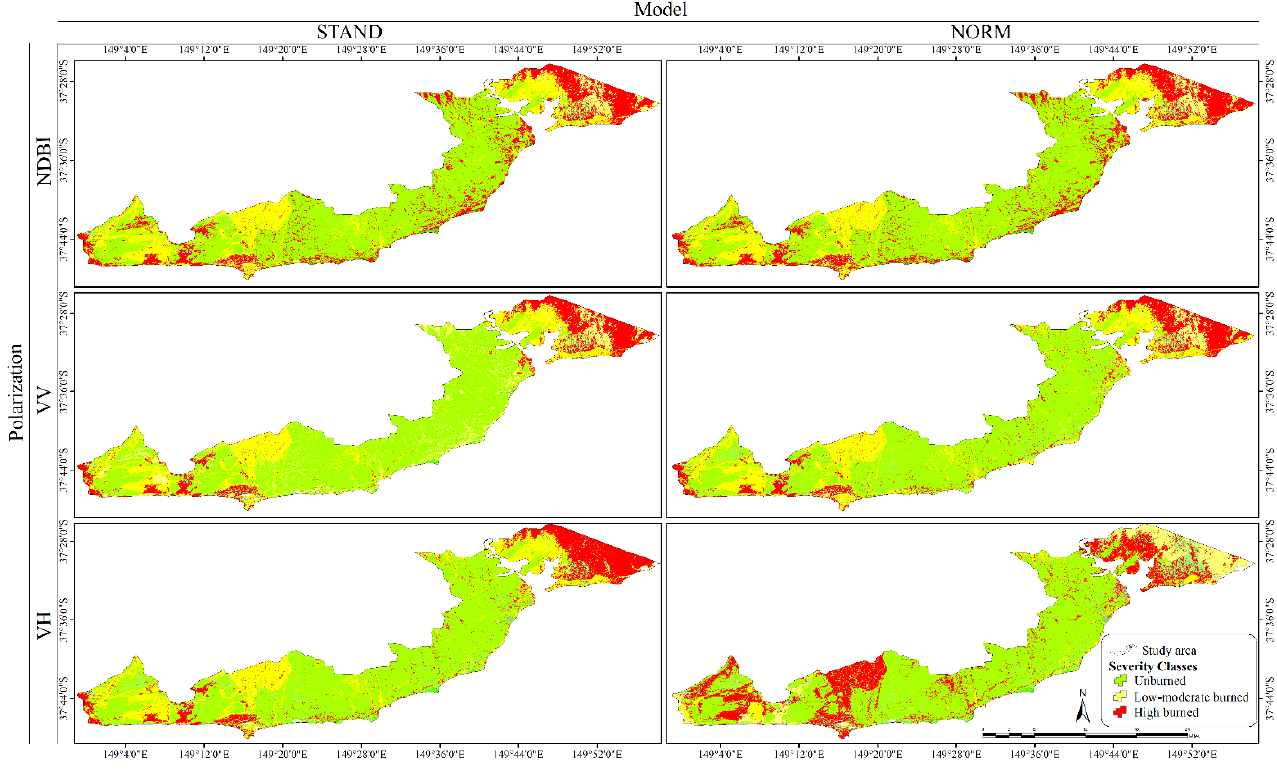
Figure A1. Dry condition.